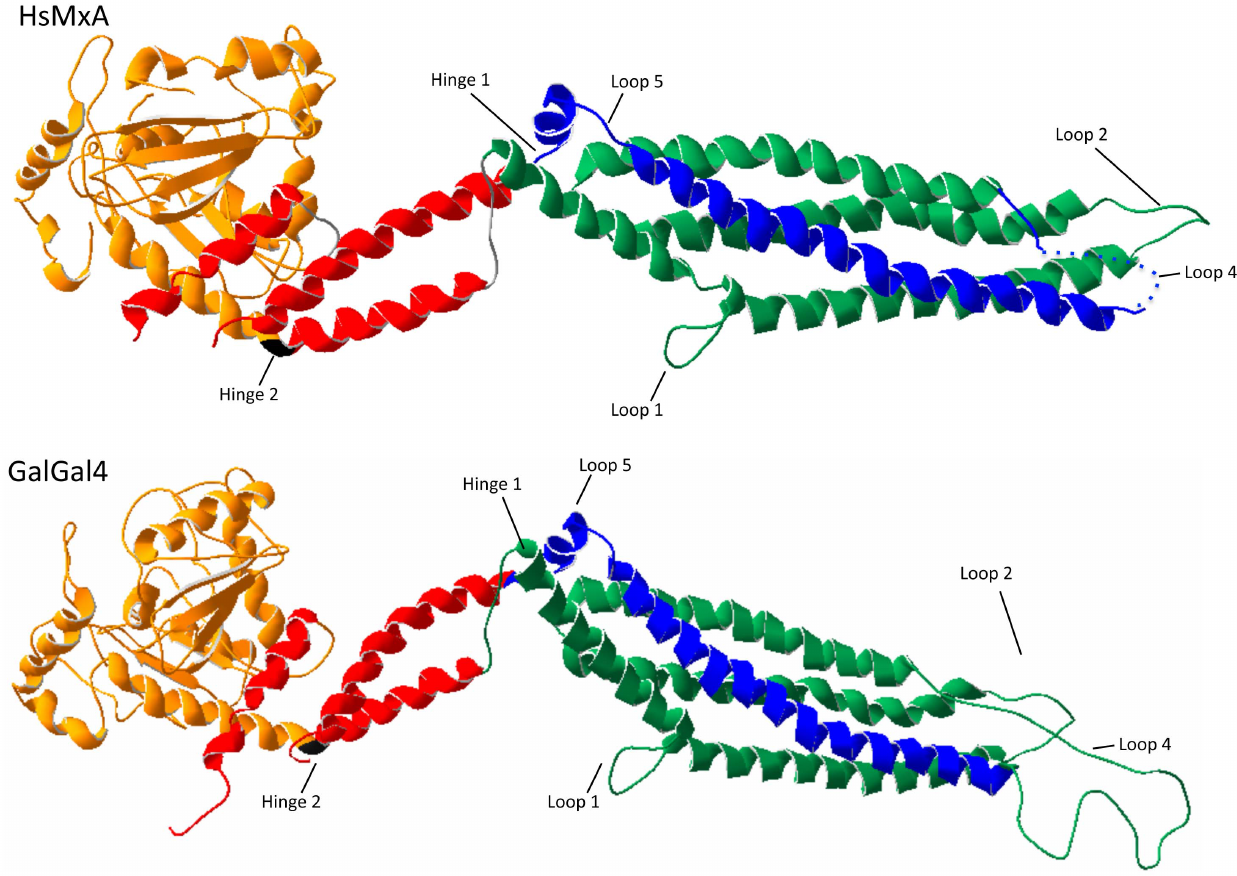
Figure 2. Predicted chicken Mx structure. The chicken Mx sequences were each analyzed using the RaptorX protein structure prediction server. These results identified the crystal structure of human MxA (PDB ID: 3SZR) as the most closely related to the chicken Mx sequence. These results where then visualized using PolyMol, and the regions of the HsMxA (aa # s) and chicken Mx (aa # s) compared. As before the GTPase Domain is shown in orange, the bundle signaling elements are in red, the stalk region which is comprised of the central dyanmin region and the GTPase effector domain are shown in green and blue respectively. The conserved proline residue that forms the hinge between the G-domain and the second BSE is shown in black.